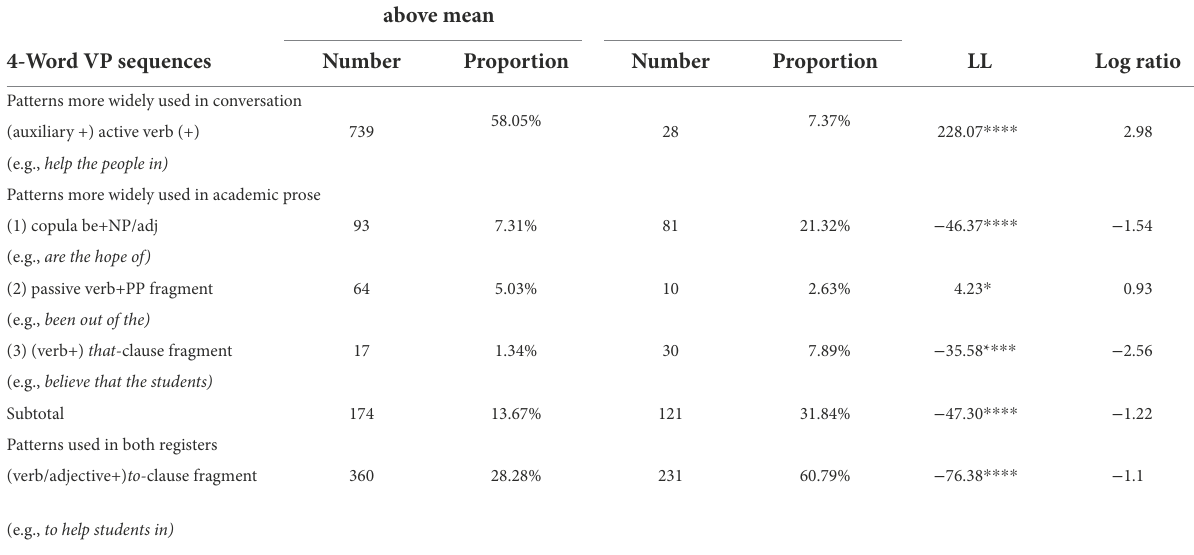
TABLE 8 Distribution of nativelike VP sequences in different MI levels. Mean and one or more